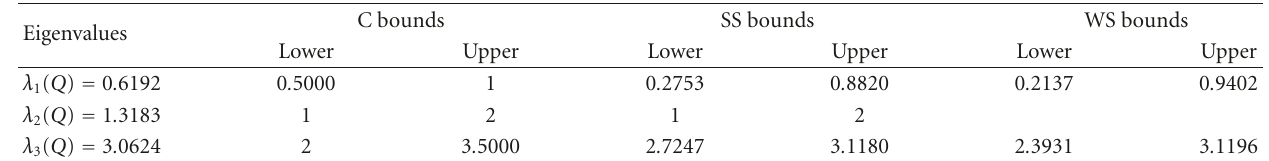
Table 3: C bounds, SS bounds, and WS bounds for Example